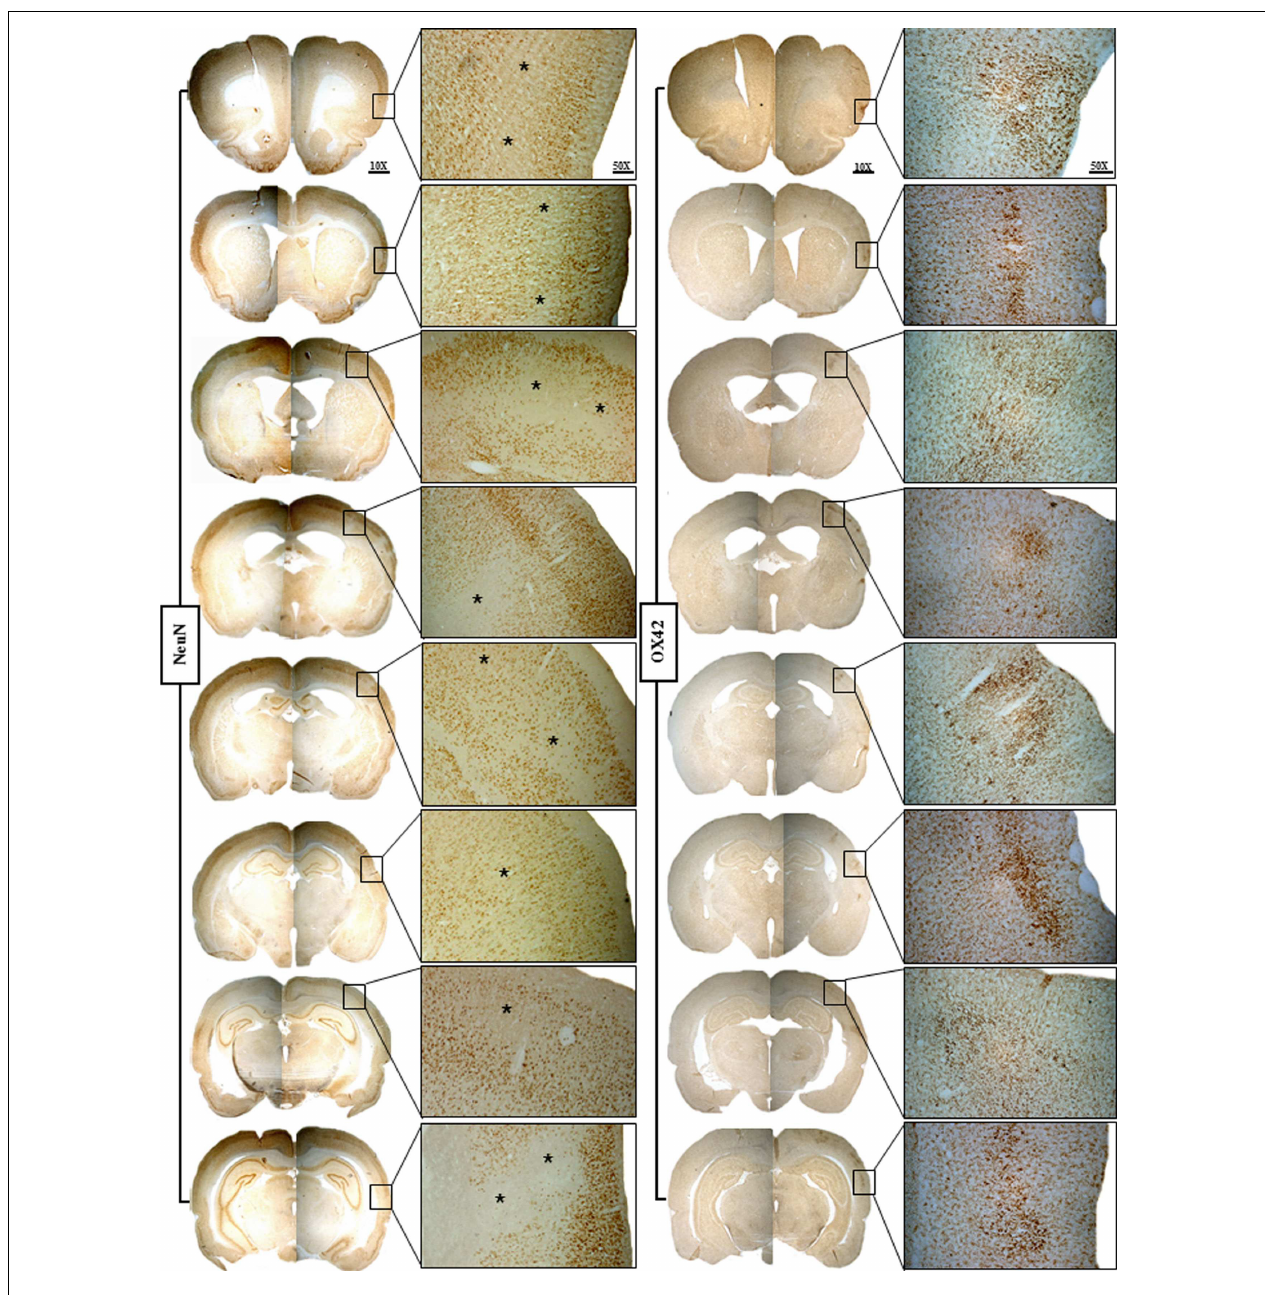
congruence of NeuN and OX42 changes in the affected cortical areas. Karyolysis, karyorrhexis, nuclear pyknosis, and patches of selective neuronal loss (SNL; *) are evident on NeuN, while increased population of highly activated microglia matching the areas of SNL is evident on OX42, an association typical for recent